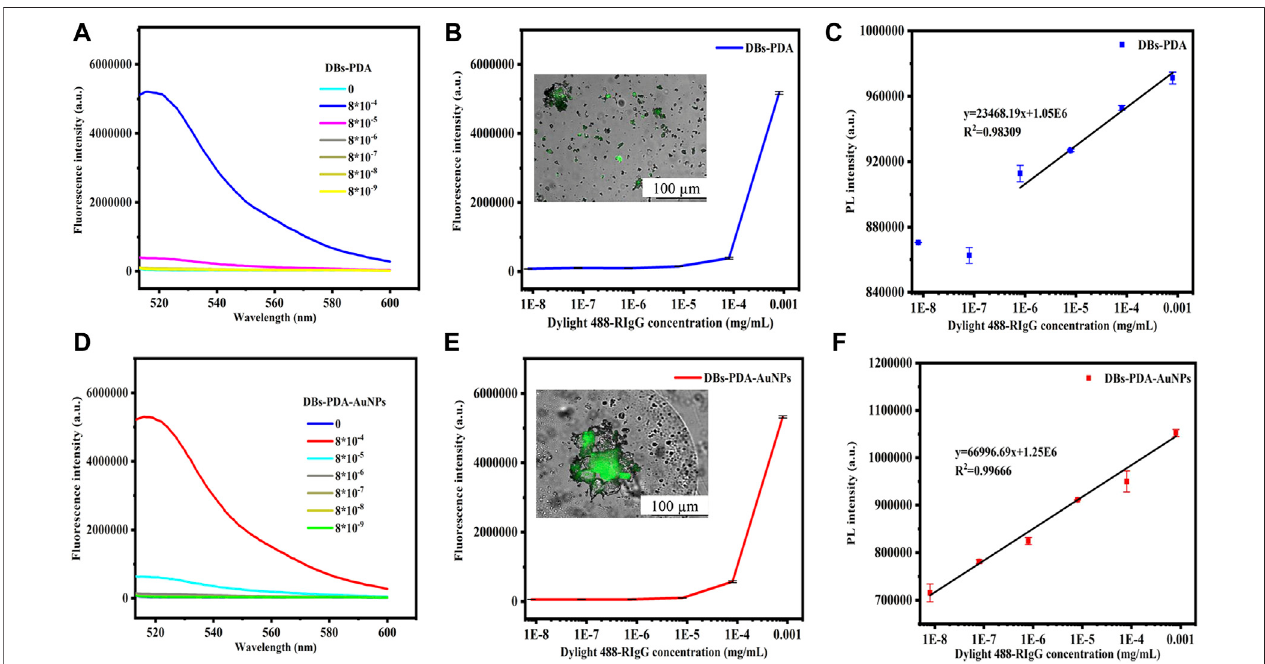
FIGURE 9 | Fluorescence spectra of GaR-functionalized (A) DBs-PDA and (D) DBs-PDA-AuNPs challenged with DyLight 488-RIgG with concentrations from 8 × 10 − 9 to 8 × 10 − 4 mg/ml. Peak fl uorescence intensity variations of GaR-functionalized (B) DBs-PDA and (E) DBs-PDA-AuNPs versus DayLight 488-RIgG with different concentrations (from 8 × 10 − 9 to 8 × 10 − 4 mg/ml). Inset: fl uorescence images of (B) GaR-functionalized DBs-PDA and (E) DBs-PDA-AuNPs challenged with DyLight 488-RIgG,respectively.Excitationwavelengthwas488 nm. PLemission spectra ofgoat-anti-RIgG-functionalized (C) DBs-PDAand (F) DBs-PDA-AuNPsbinding